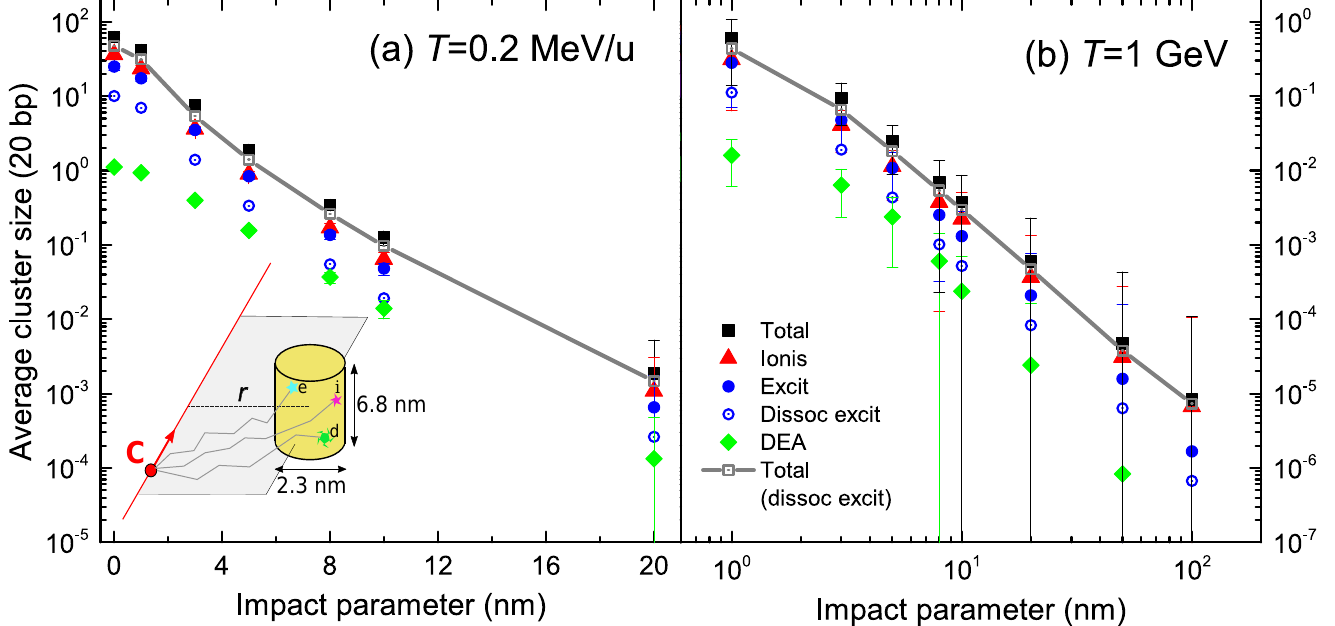
Figure 12. Average cluster size in a sensitive volume of liquid water having the dimension of two DNA turns, as a function of the impact parameter r from the ion path. Results for two kinetic energies are depicted: ( a ) T = 0.2 MeV/u and ( b ) T = 1 GeV. Symbols correspond to clusters produced by a single type of event: ionisations (red triangles), excitations (blue circles), dissociative excitations (blue hollow circles), dissociative electron attachments (DEA) (green diamond). The total average cluster size including all the events is shown by black squares, while that only including the damaging events is depicted by gray squares. The letters in the inset of panel (a) representing the sensitive cylindrical volume refer to excitation (e), ionisation (i) and DEA